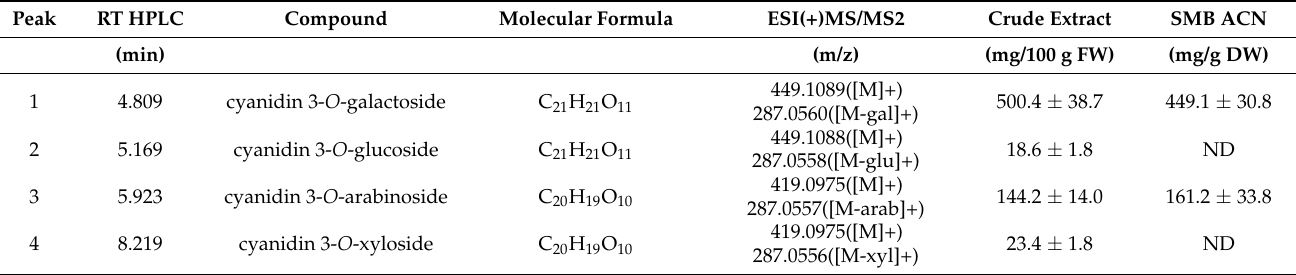
Figure 3. ( A ) HPLC-PDA chromatogram and UV-VIS scanning spectra of the black chokeberry anthocyanins crude extract at 520 nm and peak identities (1: cyanidin 3- O -galactoside; 2: cyanidin 3- O -glucoside; 3: cyanidin 3- O -arabinoside; 4: cyanidin 3- O -xyloside); ( B ) HPLC-PDA chromatogram of the SMB ACN at 520 nm and peak identities (1: cyanidin 3- O -galactoside; 2: cyanidin 3- O -arabinoside); The UPLC-QTOF-MS mass spectra and structure of cyanidin 3- O -galactoside ( C ) and cyanidin 3- O -arabinoside ( D ) of the SMB ACN peak 1 and peak 2. Table 2. HPLC quantification and UPLC-QTOF-MS identification of anthocyanins in Black chokeberry crude extract and SMB ACN.